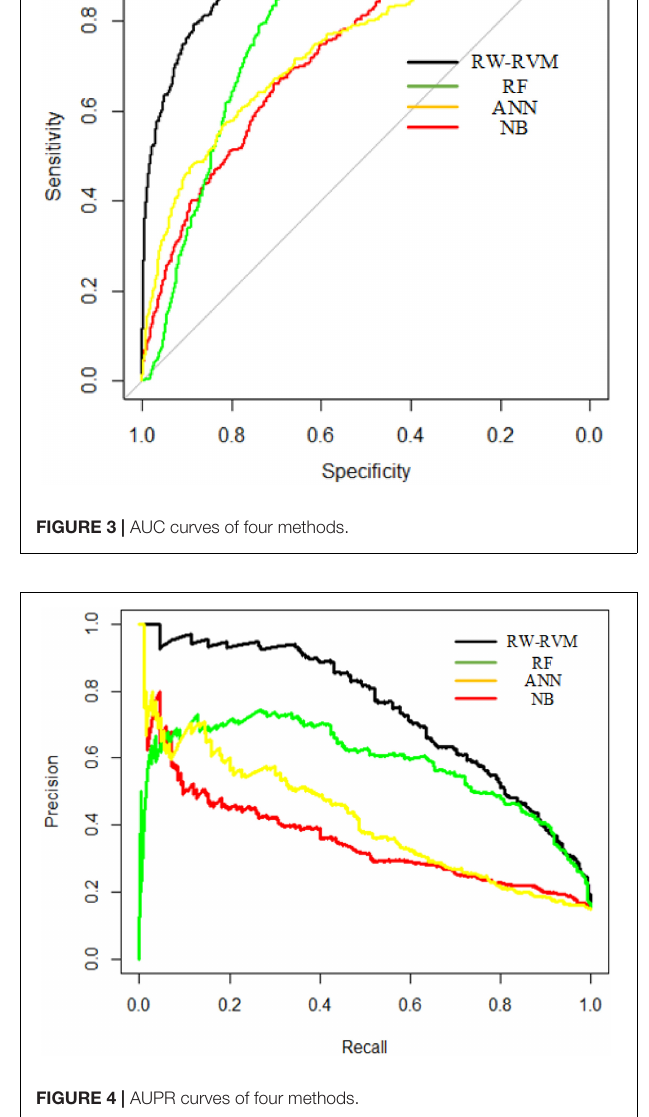
FIGURE 4 | AUPR curves of four